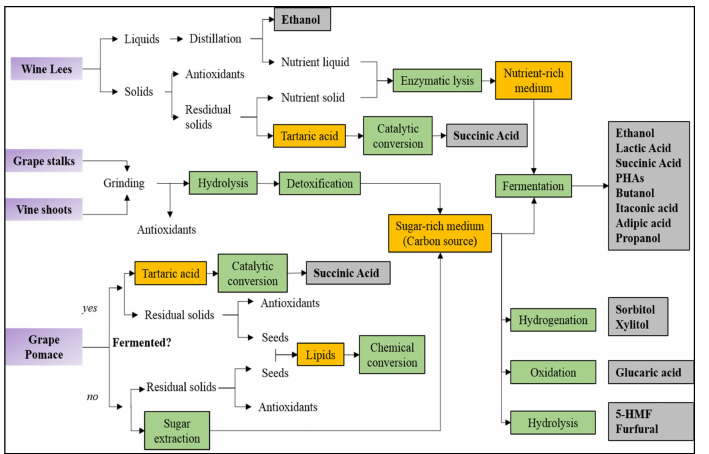
Figure 6. Proposed routes for the valorization of solid winemaking by-products as feedstocks for the fabrication of bio-based